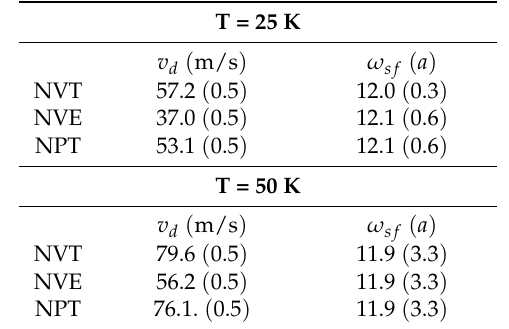
Figure 12. Time-accumulated average displacement of the dissociated edge dislocations expressed as a function of time, temperature, and simulated thermodynamic ensemble ( n = 18,424 atoms). Solid lines represent the actual dislocation positions and dashed lines are linear fits performed on regions in which the dislocation motion is not disturbed by the simulation cell boundaries. Dislocation diffusion velocities are deduced directly from the slope of the linear fits. Table 1. Average width of the fcc-like stacking fault, ω sf , and edge dislocation diffusion velocity, v d , expressed as a function of temperature, and simulated thermodynamic ensemble ( n = 18,424 atoms). ω sf results are expressed in units of lattice parameter a and the figures within parentheses indicate the corresponding statistical